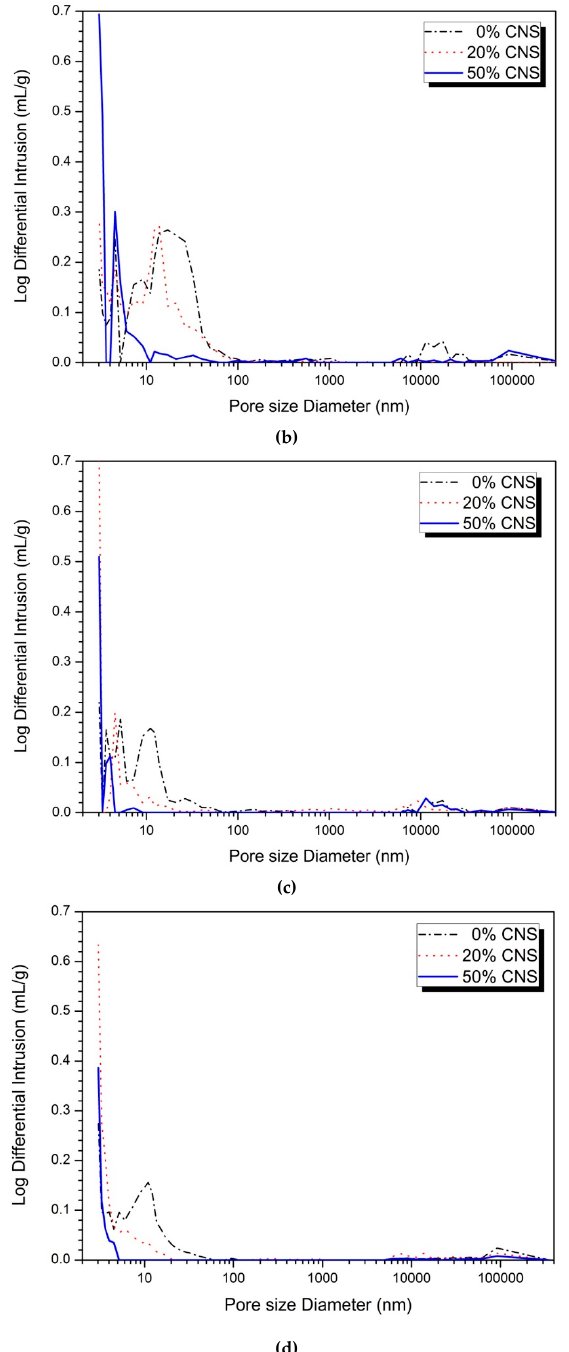
Figure 6. MIP analysis: ( a ) 5% activator, 1-day, ( b ) 5% activator, 28-day, ( c ) 10% activator, 1-day, ( d ) 10% activator,